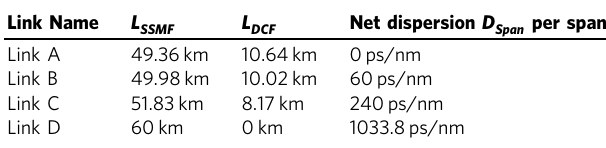
Table 1 Link con fi gurations in which the impact of sphere shaping is